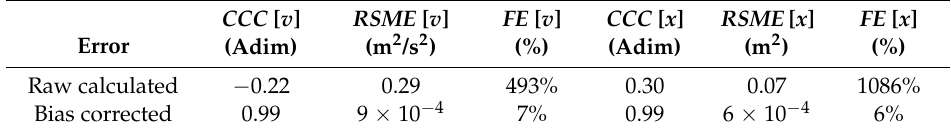
Figure 17. Experimental and calculated results of velocity and displacement in Z axis; ( a ) raw calculated results; ( b ) bias corrected calculated results. Table 5. Quality indicators in the Z axis signal calculations; Velocity [ v ] and displacement [ x ].